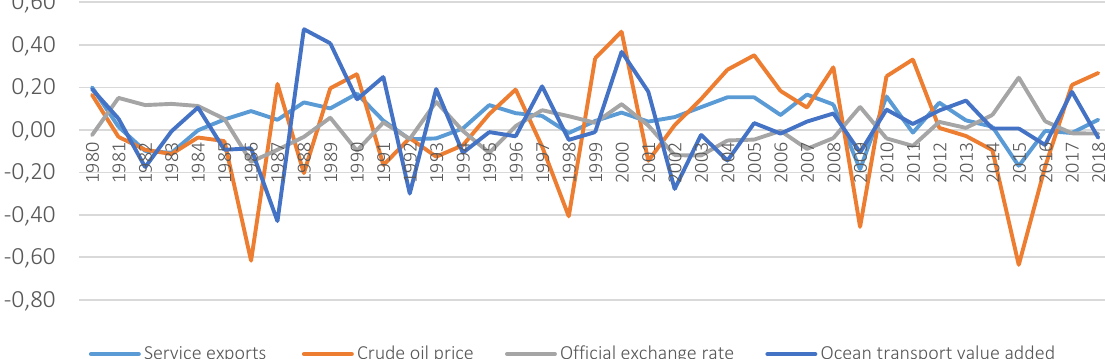
Figure 2. Development in crude oil prices, services export, official exchange rate NOK to USD and ocean transport value added in Norway during the period